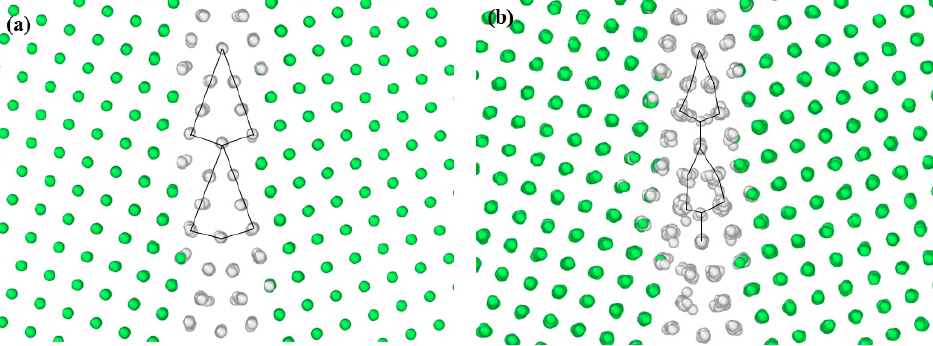
Figure 1. Structures of grain boundaries (GBs) simulated at ( a ) 1000 K and ( b ) 2000 K. Oxygen atoms are removed for clarity. The atoms in the GB and bulk regions are colored white and green, respec- tively.